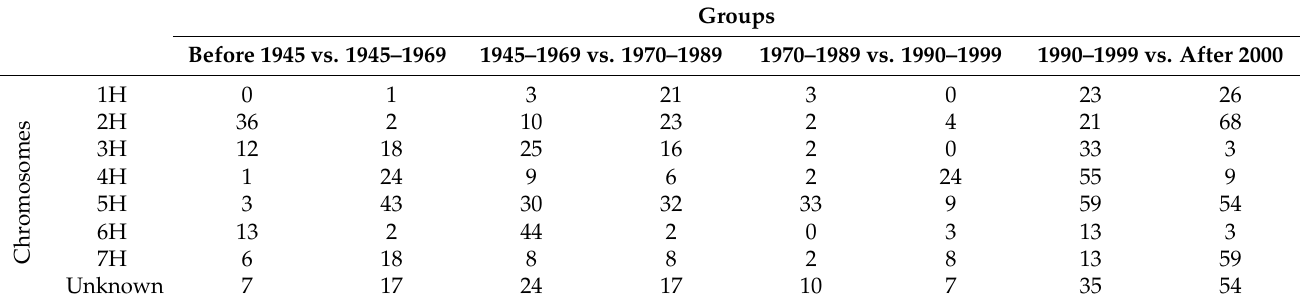
Table 3. Change in the number of unique alleles in consecutive breeding periods considering chromosome allocation. Results based on DArTseq analysis for 83 spring barley cultivars. Groups